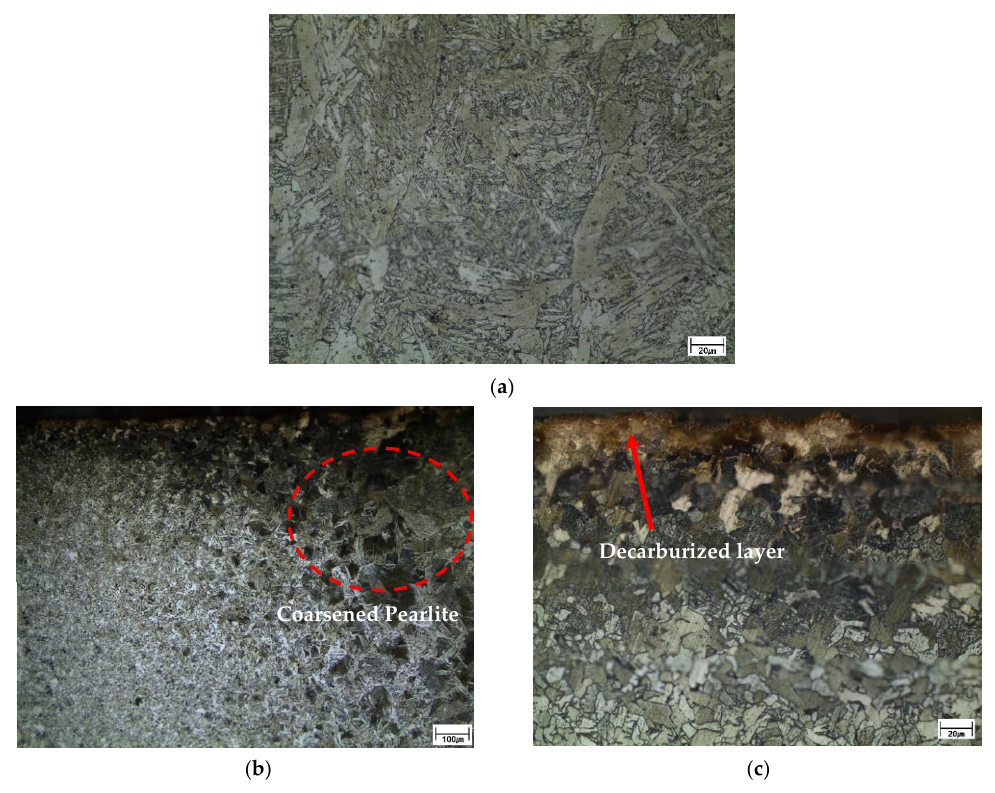
Figure 6. Microstructures of overlap-defect specimen without peening. ( a ) Center of the bead; ( b ) Heat-affected zone (HAZ); ( c ) Upper part of HAZ. ( b ) Low- and ( a , c ) high-magnification. The specimen with the peened overlap defect was observed under OM. The compres- sion effect caused by peening was observed on the HAZ surface. Figure 7a,b show low- and high-magnification images, respectively, of the compressed layer on the surface of the HAZ after ultrasonic peening. The high-magnification image confirmed the compression based on the shape of the ferrite and pearlite grains. These changes were attributed to the effect of surface compression caused by the local plastic deformation during peening. The SEM image in Figure 7c clearly shows the surface compression layer of the HAZ area caused by ultrasonic peening. This layer was approximately 10 µm thick, with the grain boundaries disappearing due to the compression. Figure 7d shows a high-magnification SEM image of the surface of the weld bead, with no significant change observed in the microstructure because of the compression effect. In addition, it appears that the decarbu- rized layer at the top of the HAZ before peening was compressed. When decarburization occurs, carbon in Fe 3 C in the pearlite structure escapes, leaving a soft ferrite structure. By Table 1. Microhardness of welded specimens at different depths and peening, the decarburized layer was work-hardened and turned into a compressed layer on the surface.